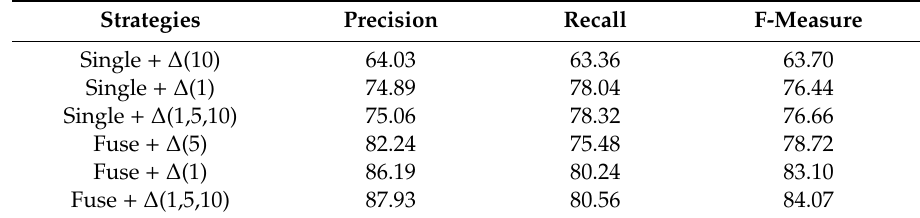
Table 2. Performances of various networks and di ff erent delta ( ∆ ) on the ICDAR2013 dataset (%).